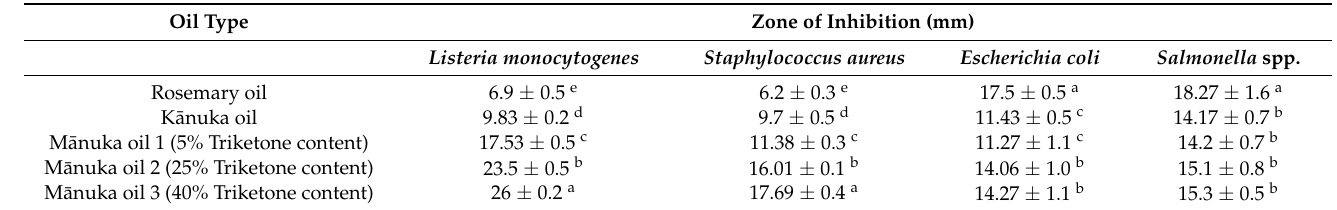
Table 1. The inhibition zone values were observed for mānuka, kanuka, and rosemary oils against different microorganisms.